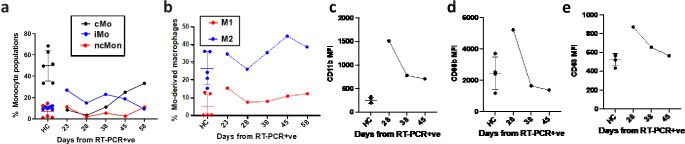
Kinetics of the innate immune response in the COVID-19 patient.(a) Percentages of CD14+ CD16- classical monocytes (cMo), CD14+ CD16+ intermediate monocytes (iMo) and CD14- CD16+ non classical monocyes (ncMo). Percentages are calculated in live, CD3-, CD66b-, HLA-DR+ cells in the COVID-19 patient and in healthy controls (n = 6). (b) Percentages of blood monocyte-derived M1 (CD14+ CD80+ CD68+) and M2 (CD14+ CD163+ CD68+) macrophages are shown for the COVID-19 patient and healthy controls. (c–e) Neutrophil degranulation measured as MFI of CD11b (secretory vesicles), CD66b (secondary granules) and CD63 (primary granules) is shown for the patient and healthy controls (n = 4). Neutrophils were immunostained in whole blood, followed by erythrocyte lysis with ACK buffer and fixation with 4% PFA prior for analysis by flow cytometry. Blood monocytes and monocyte-derived macrophages were stained from PBMCs isolated by Ficoll gradient as described in the methods section.